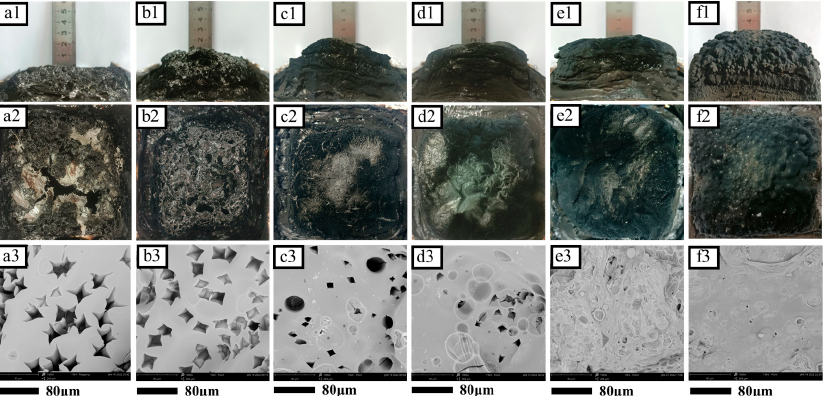
Figure 4. Digital photograph and SEM of carbon residue after cone calorimetry test of EP composite ( × 1000). EP ( a1 , a2 , a3 ), 4%TAD/EP ( b1 , b2 , b3 ), 3%TAD/1%Zn-PDH/EP ( c1 , c2 , c3 ), 2%TAD/2%Zn- PDH/EP ( d1 , d2 , d3 ), 1%TAD/3%Zn-PDH/EP ( e1 , e2 , e3 ), and 4%Zn-PDH/EP ( f1 , f2 , f3 ).